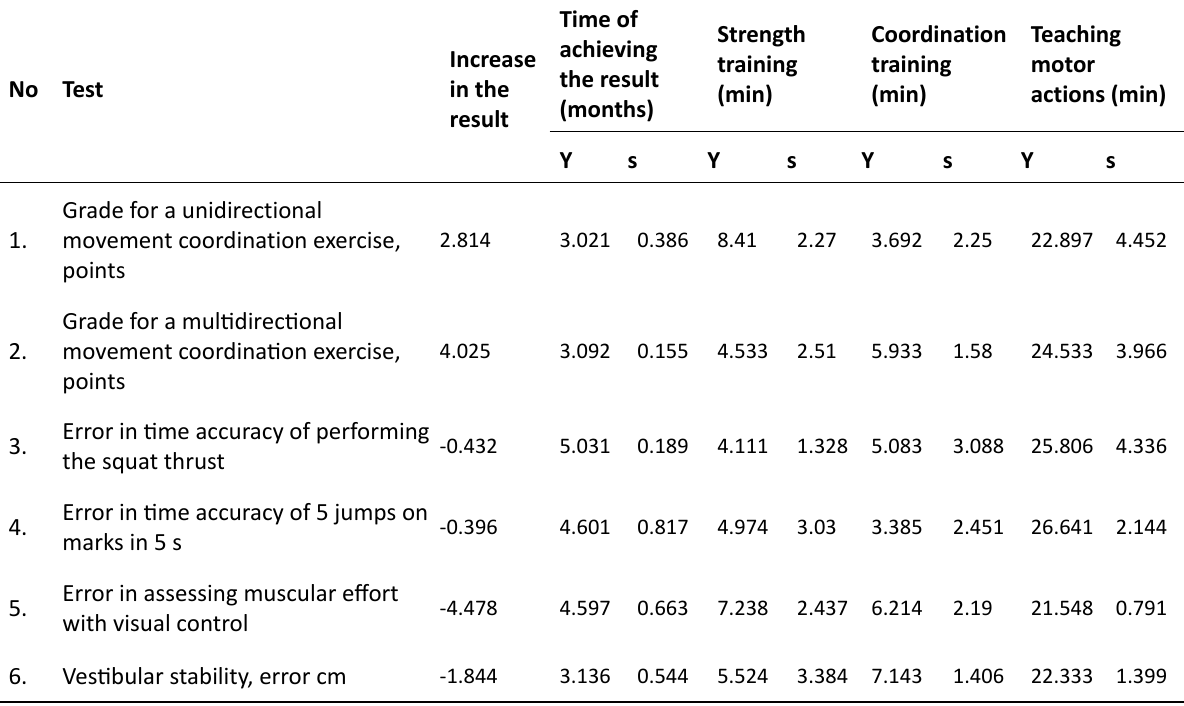
Table 5. Ratio between the means of strength and coordination training in the physical education class of boys aged 8-9 years